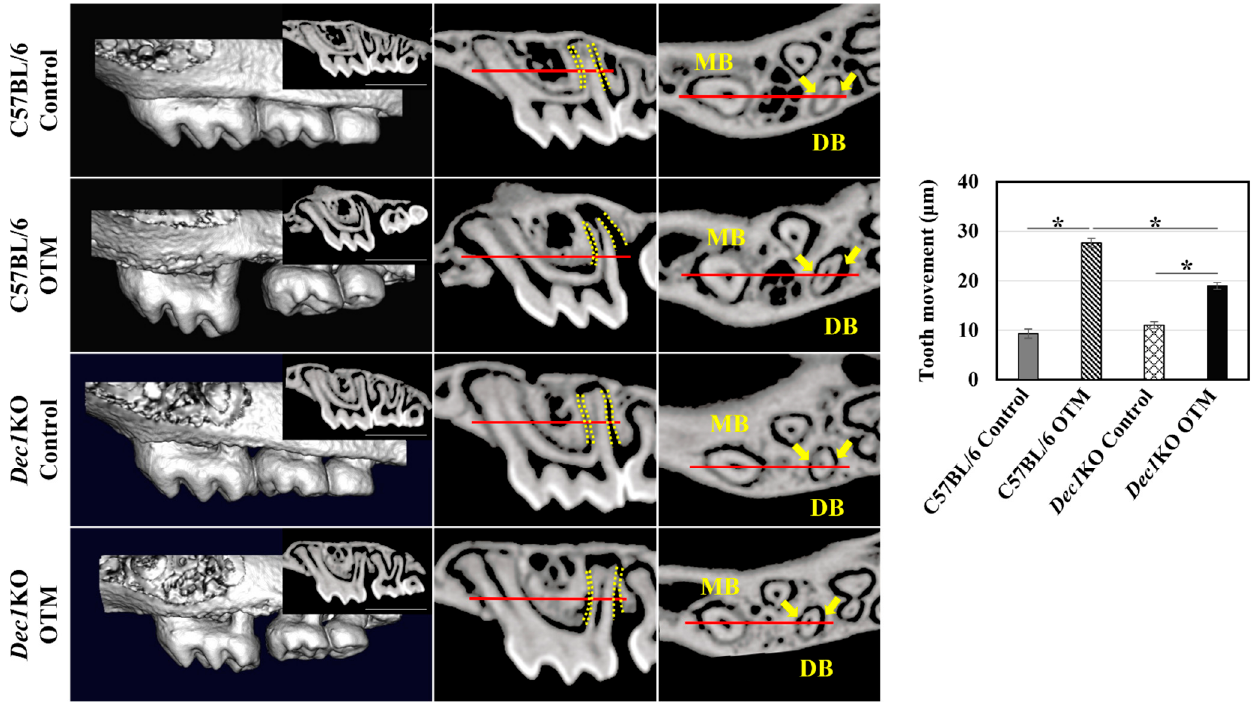
Figure 7. OTM and PDL width measurements. 3D images showing that the distance between the first and second molars in the WT OTM mice is much wider than in the Dec1 KO OTM mice. OTM was quantified by measuring the minimum distance between the maxillary first and second molar crowns. Scale bars = 1 mm. The average PDL width was quantified by measuring the mean PDL space on the distal aspect of the distobuccal root in sagittal micro-CT images. The mid-root PDL width was measured in the horizontal micro-CT images. MB, mesiobuccal root; DB: distobuccal root. The data shown represent the means ± SD of at least three independent experiments; * p < 0.05.